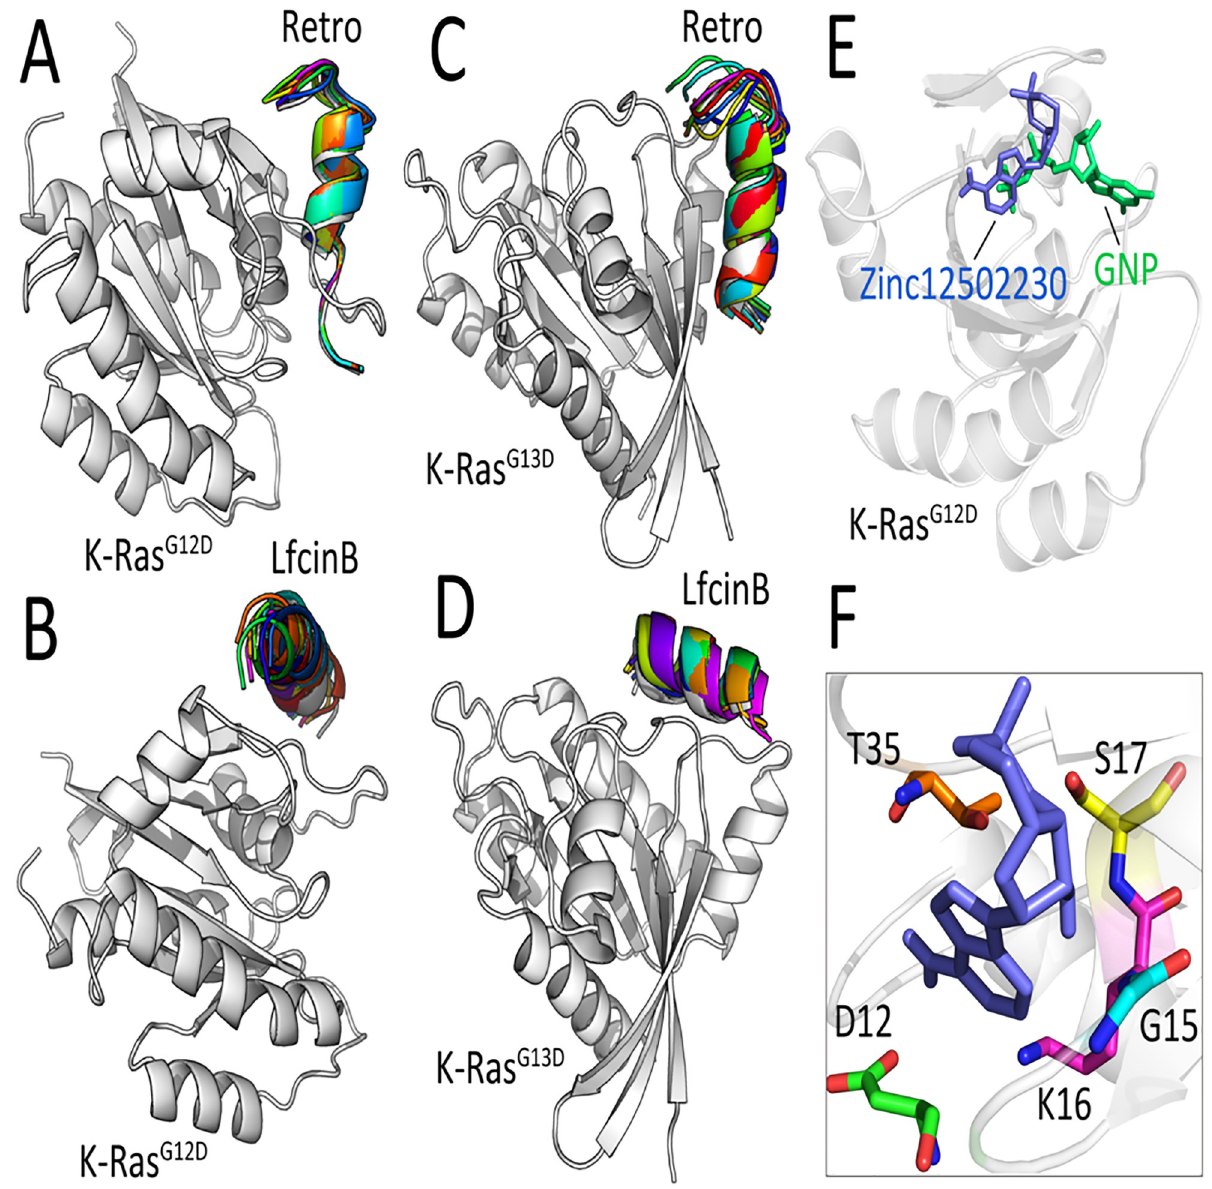
Fig 4. Interaction mode of peptides/molecule with K-Ras G12D and K-Ras G13D . Superimposition of top-ranked peptide-protein docked poses resulted from flexible docking of ( A ) the modified Retro-Kras G12D , ( B ) the modified LfcinB- Kras G12D , ( C ) the modified Retro-Kras G13D , and ( D ) the modified LfcinB-Kras G13D . ( E ) Superimposition of GNP-bound (green) and Zinc12502230-bound (blue) K-Ras G12D . ( F ) Close-up view of H-bonding interactions between Zinc12502230 (blue) and five residues of K-Ras G12D colored in different colors.